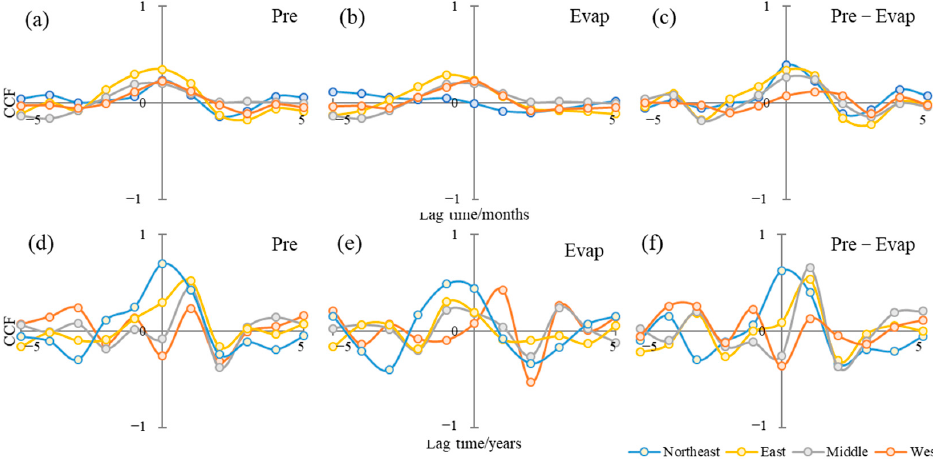
Figure 7. The cross-correlation coefficients (CCF) between precipitation ( a ), evapotranspiration ( b ) and precipitation minus evapotranspiration ( c ) with TWS changes on monthly and precipitation ( d ), evapotranspiration ( e ), and precipitation minus evapotranspiration ( f ) with TWS changes on annual time scales (Pre: Precipitation as input; Evap: Evapotranspiration as input; Pre–Evap: Precipitation minus evapotranspiration as input).